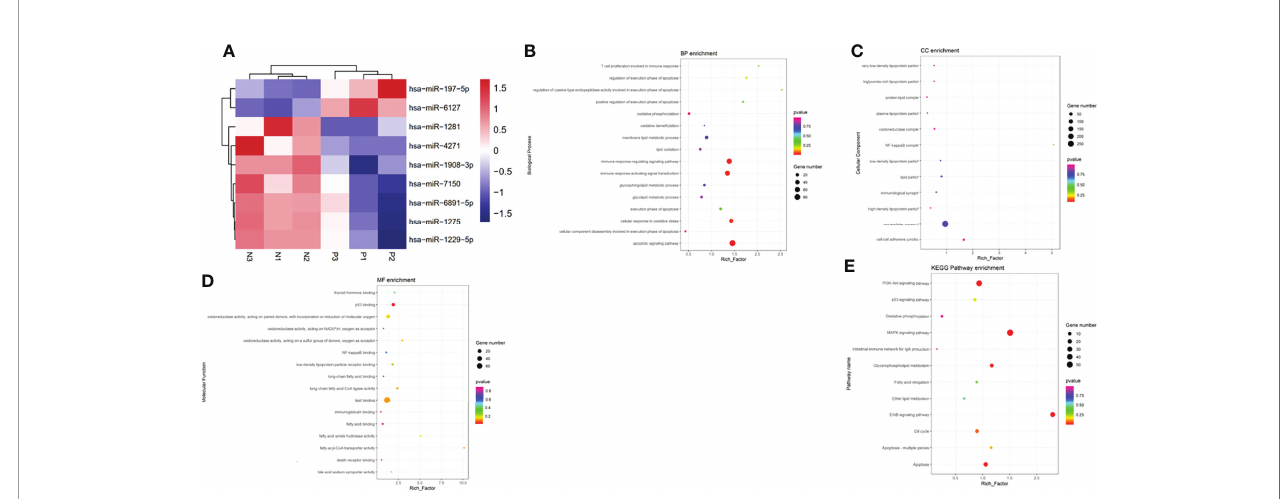
FIGURE 2 | Bioinformatics analysis of differentially expressed serum exosome miRNAs. (A) Cluster analyses of differentially expressed miRNAs in the serum exosome of pregnant women with ICP (P) and healthy pregnant women (N). Hierarchical cluster analyses of the nine differentially expressed miRNAs displaying signi fi cantly altered expression levels in patients with ICP. Expression levels are shown as colored boxes; red, high level; blue, low level. (B) GO classi fi cations and enrichments in terms of BP. (C) GO classi fi cations and enrichments in terms of CC. (D) GO classi fi cations and enrichments in terms of MF. (E) KEGG pathway enrichment analyses.